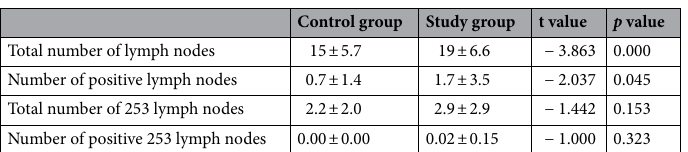
Table 2. The comparison of lymph node acquisition between control and study